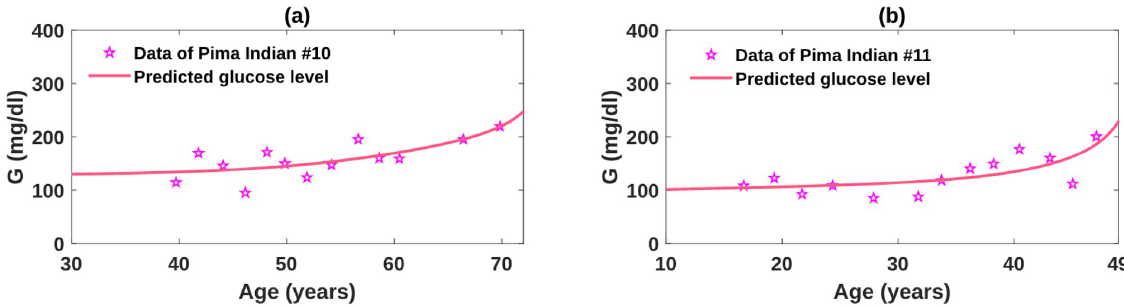
Fig 10. Obesity-related diabetes model fit to plasma glucose data with large fluctuations for Pima Indian #10 and #11.